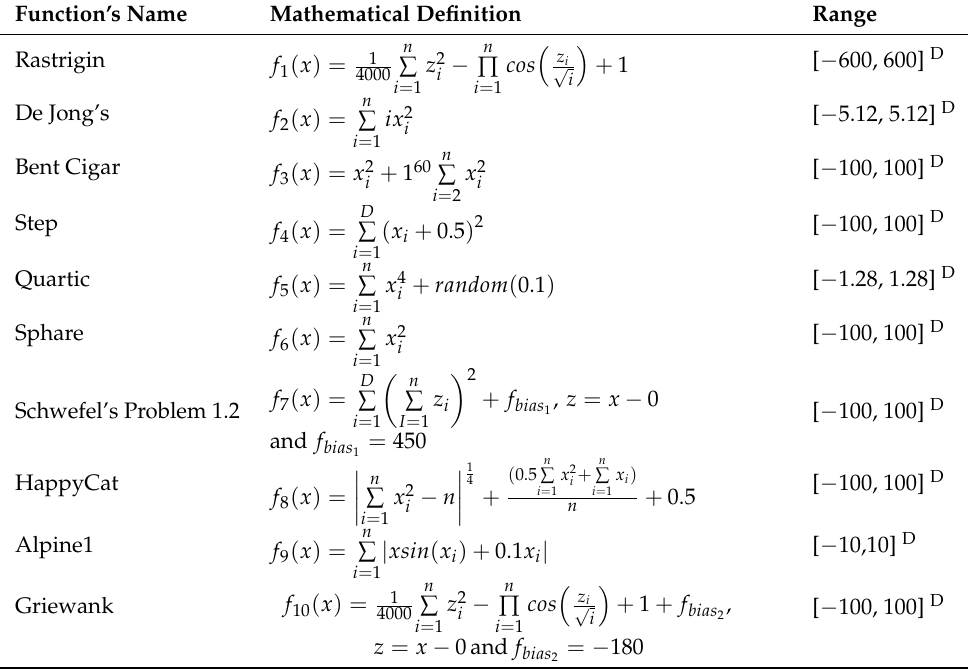
Table 1. High Dimensional Classical Benchmark